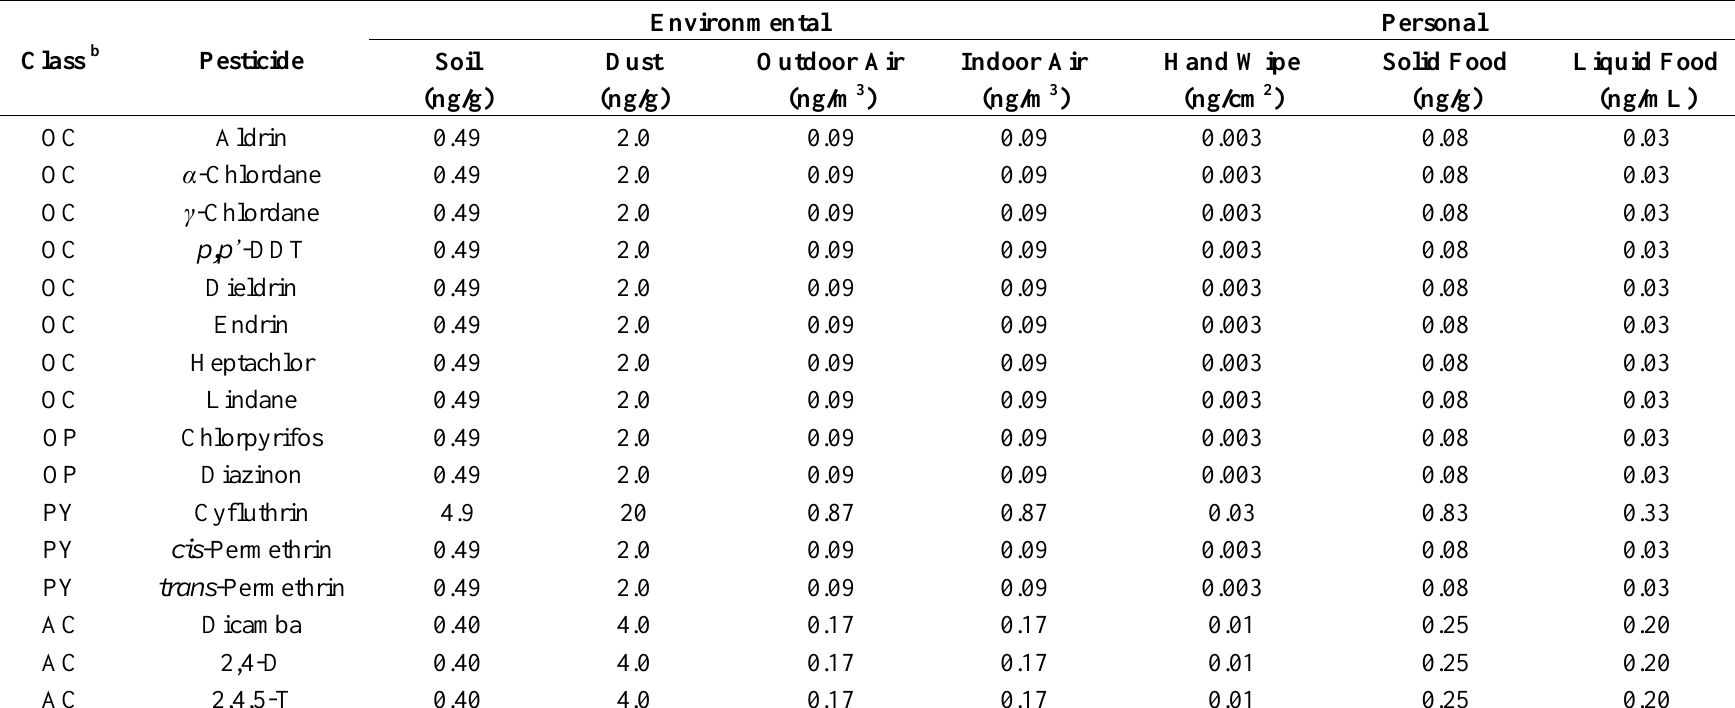
Table 1. Estimated limits of detection (LODs) for the target pesticides in environmental and personal media a